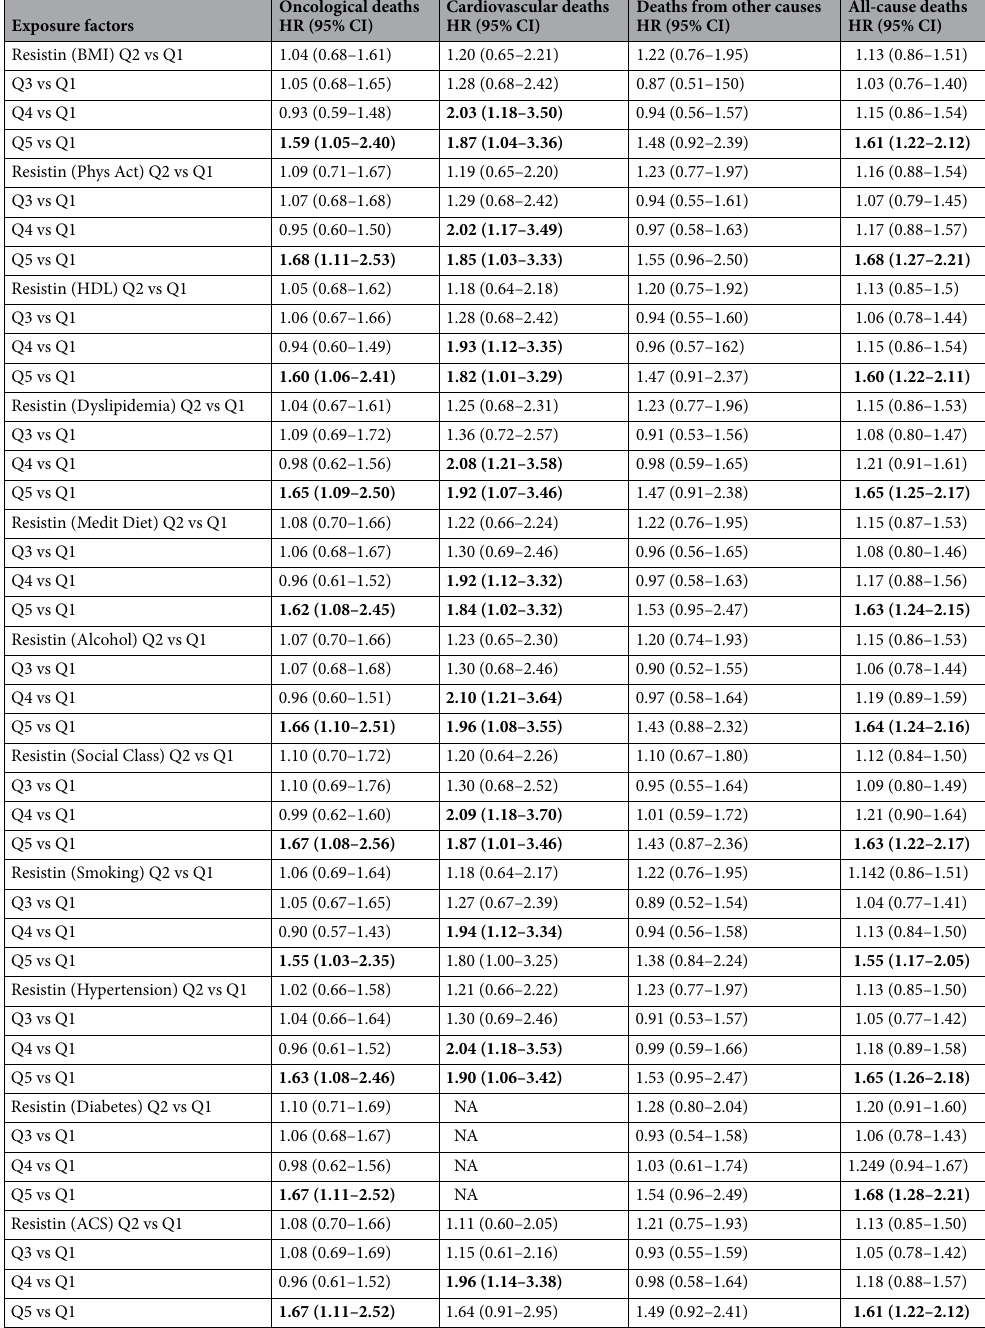
Table 2. Association between resistin and mortality. The effect of resistin was adjusted in eleven models for each type of mortality. The models included age and sex, plus one of the exposure factors, and they were summarized with the HR (95% CI) among resistin categories. ACS Acute coronary syndrome, NA Not applicable. Significant values are in